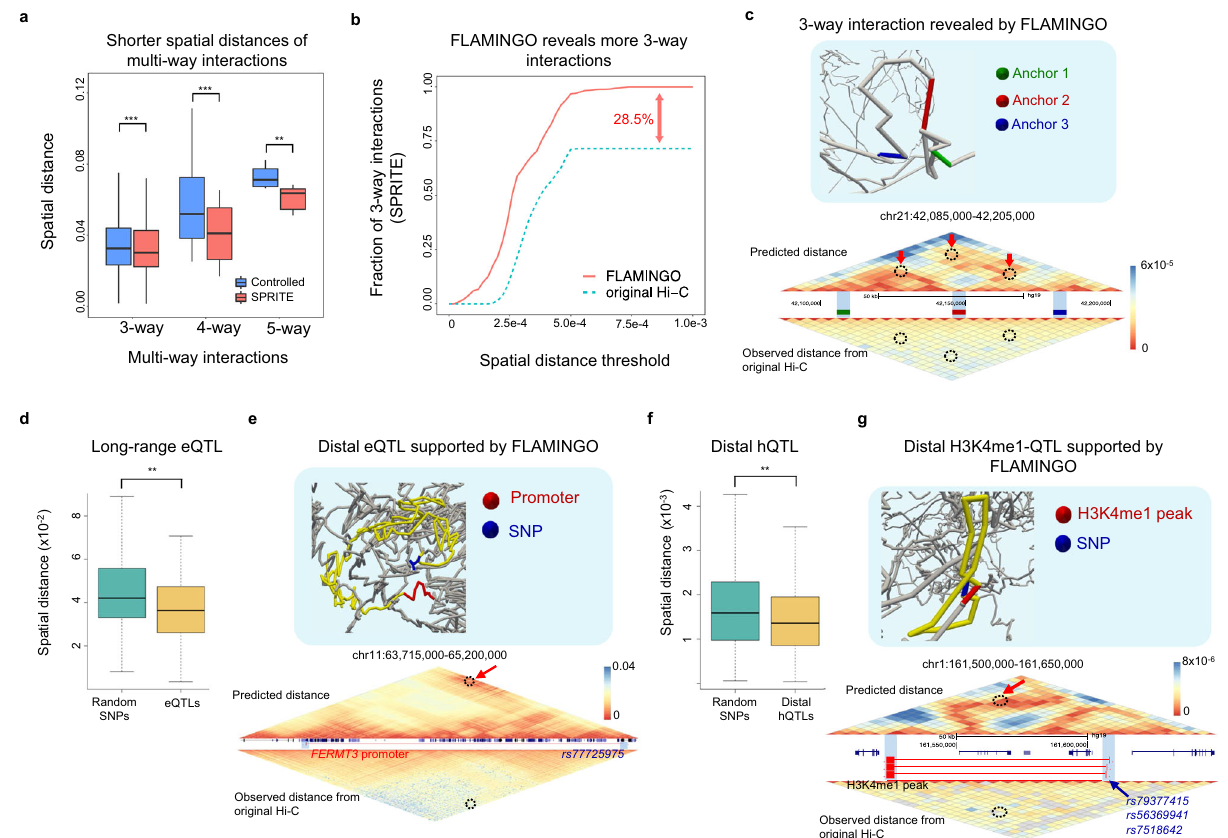
Fig. 4 FLAMINGO interprets multi-way chromatin interactions and QTLs based on predicted 3D neighborhoods. a SPRITE multi-way interactions on chr21 are predicted with shorter spatial distances than the genomic-distance controlled background (** p -value < 10 − 2 , *** p -value < 10 − 3 ; one-sided Wilcoxon test). The x -axis corresponds to 3-way ( p -value = 2.3 × 10 − 9 , n = 302), 4-way ( p -value = 1.9 × 10 − 4 , n = 17), and 5-way interactions ( p -value = 7.8 × 10 − 3 , n = 7). The center lines of boxplots show the median, the upper and lower box limits show the 25th and 75th percentiles respectively. The whiskers extend up to 1.5 times the interquartile range away from the limits of the boxes. Outliers outside this range were removed from the fi gure. b FLAMINGO captures more 3-way interactions across different distance thresholds, compared to using normalized Hi-C contact map derived distance matrix. c One example of a SPRITE 3-way chromatin interaction captured by FLAMINGO. d The SNP-promoter pairs of long-range eQTLs (>900 kb) are assigned with signi fi cantly shorter spatial distances by FLAMINGO, compared to genomic-distance controlled random pairs (** p -value = 4.1 × 10; − 3 one-sided Wilcoxon test, n = 1227). The center lines of boxplots show the median, the upper and lower box limits show the 25th and 75th percentiles respectively. The whiskers extend up to 1.5 times the interquartile range away from the limits of the boxes. Outliers outside this range were removed from the fi gure. e One example of long-range eQTLs interpreted by FLAMINGO. The SNP rs77725975 (blue) and the promoter of FERMT3 (red) are placed in close 3D proximity. f The SNP-H3K4me1 pairs of distal hQTLs are assigned with signi fi cantly shorter spatial distances by FLAMINGO, compared to genomic-distance controlled random pairs (** p -value = 6.3 × 10 − 3 ; one-sided Wilcoxon test, n = 20,950). The center lines of boxplots show the median, the upper and lower box limits show the 25th and 75th percentiles respectively. The whiskers extend up to 1.5 times the interquartile range away from the limits of the boxes. Outliers outside this range were removed from the fi gure. g One example of distal H3K4me1-QTLs interpreted by FLAMINGO. The SNPs rs79377415, rs56369941, rs7518642 (blue) and the H3K4me1 ChIP-seq peak (red) are placed in close 3D proximity. Source data are provided as a Source Data fi